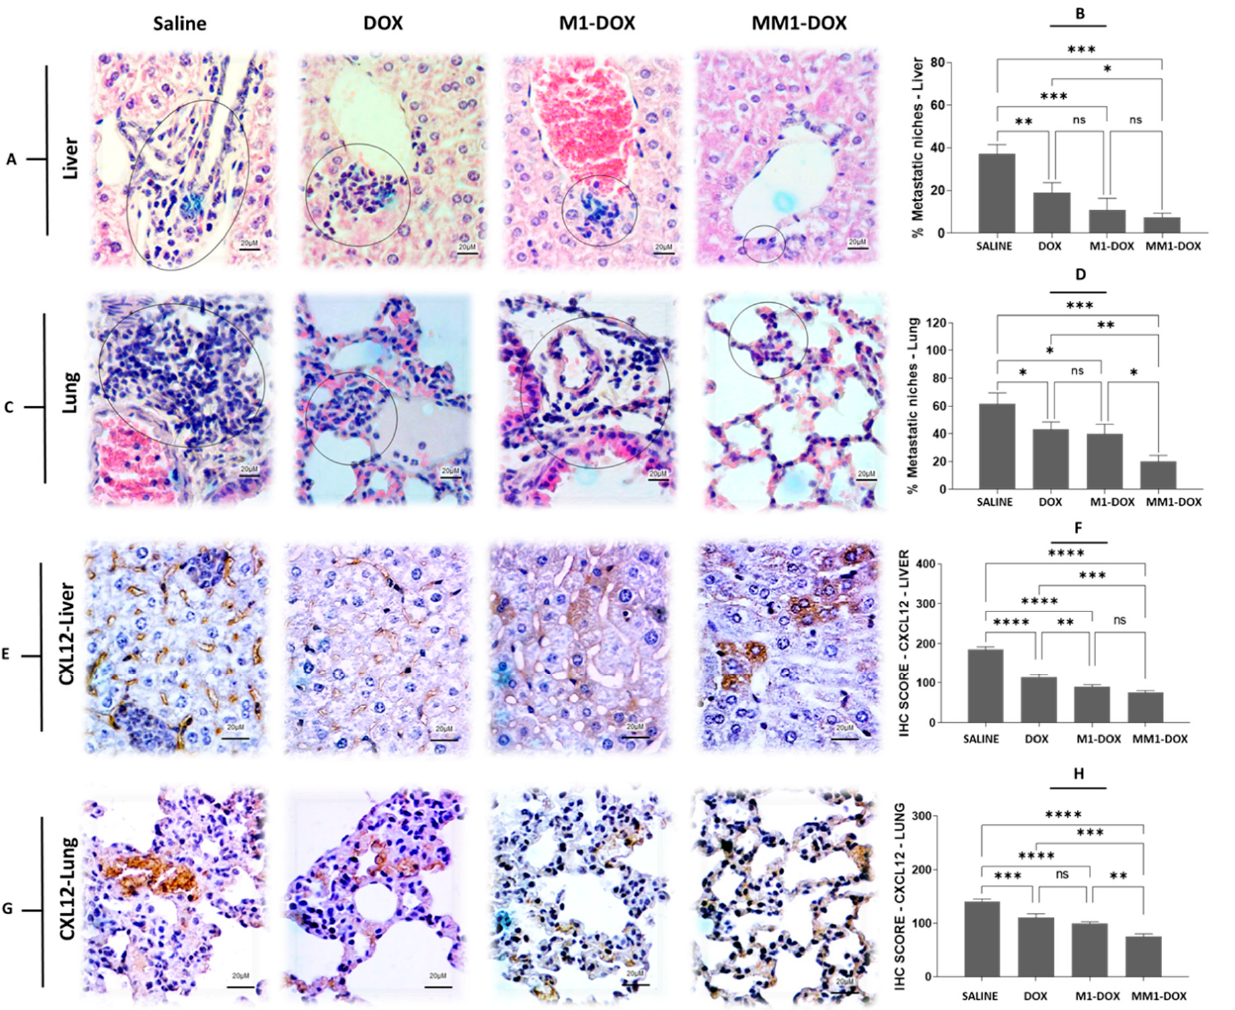
Figure 5. Influence of HA and CV on in vivo antimetastatic properties of M1-derived EVs loaded with DOX in orthotopic 4T1 breast cancer-bearing mice. ( A ) H&E staining of liver sections from treated animals showing the formation of metastatic niches. ( B ) Percentage of liver metastatic niches for the four experimental groups. ( C ) H&E staining of lung sections from treated animals showing the formation of metastatic niches. ( D ) Percentage of lung metastatic niches for the four experimental groups. ( E ) Immunohistochemical (IHC) detection of CXL12 in liver sections from treated animals. ( F ) IHC score for CXL12 from the four experimental groups. ( G ) IHC detection of CXL12 in lung sections from treated animals. ( H ) IHC score for CXL12 from the four experimental groups. Scale bars are 20 µM. Data are means ± SEM. Non-significant (ns); **** p < 0.0001; *** p < 0.001; ** p < 0.01; * p < 0.05.